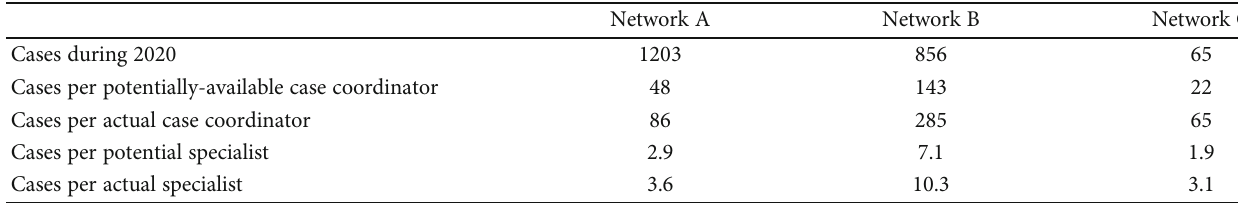
Table 10: Network e ffi ciency during the fi rst half of 2020.